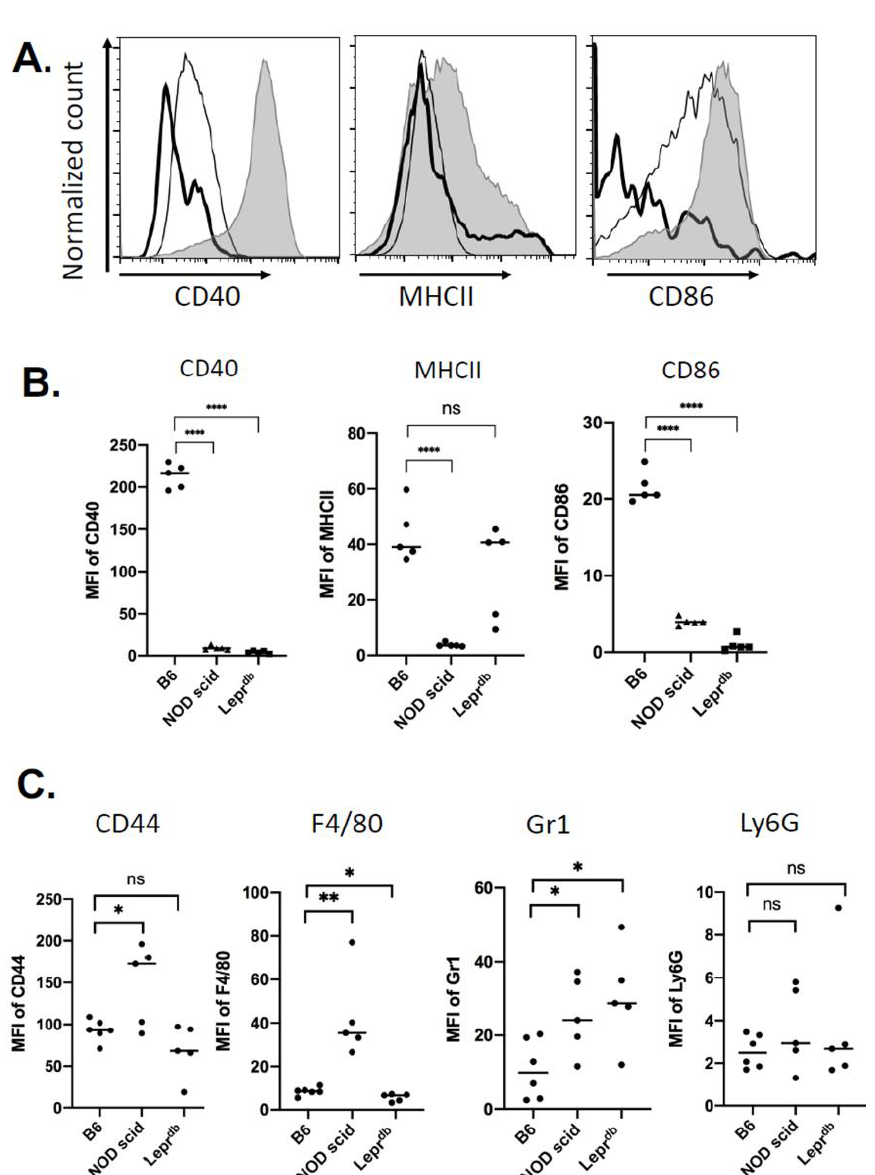
Figure 3. Immunophenotype of CD45 + CD11c + immune cells recruited in wild type, immunodeficient, and diabetic-obese mice implanted with PVA sponges. ( A ) Expression of CD40, MHCII, and CD86 in wildtype C57 BL/6 mice (shaded), immunodeficient NOD-scid mice (thin line), and diabetic-obese Lepr db mice (bold line). ( B ) Quantification in replicate mice ( n = 3), and ( C ) analysis of macrophage and granulocyte markers ( n = 5; * p < 0.05, ** p < 0.01, and **** p < 0.0001, ns = not sig- nificant).